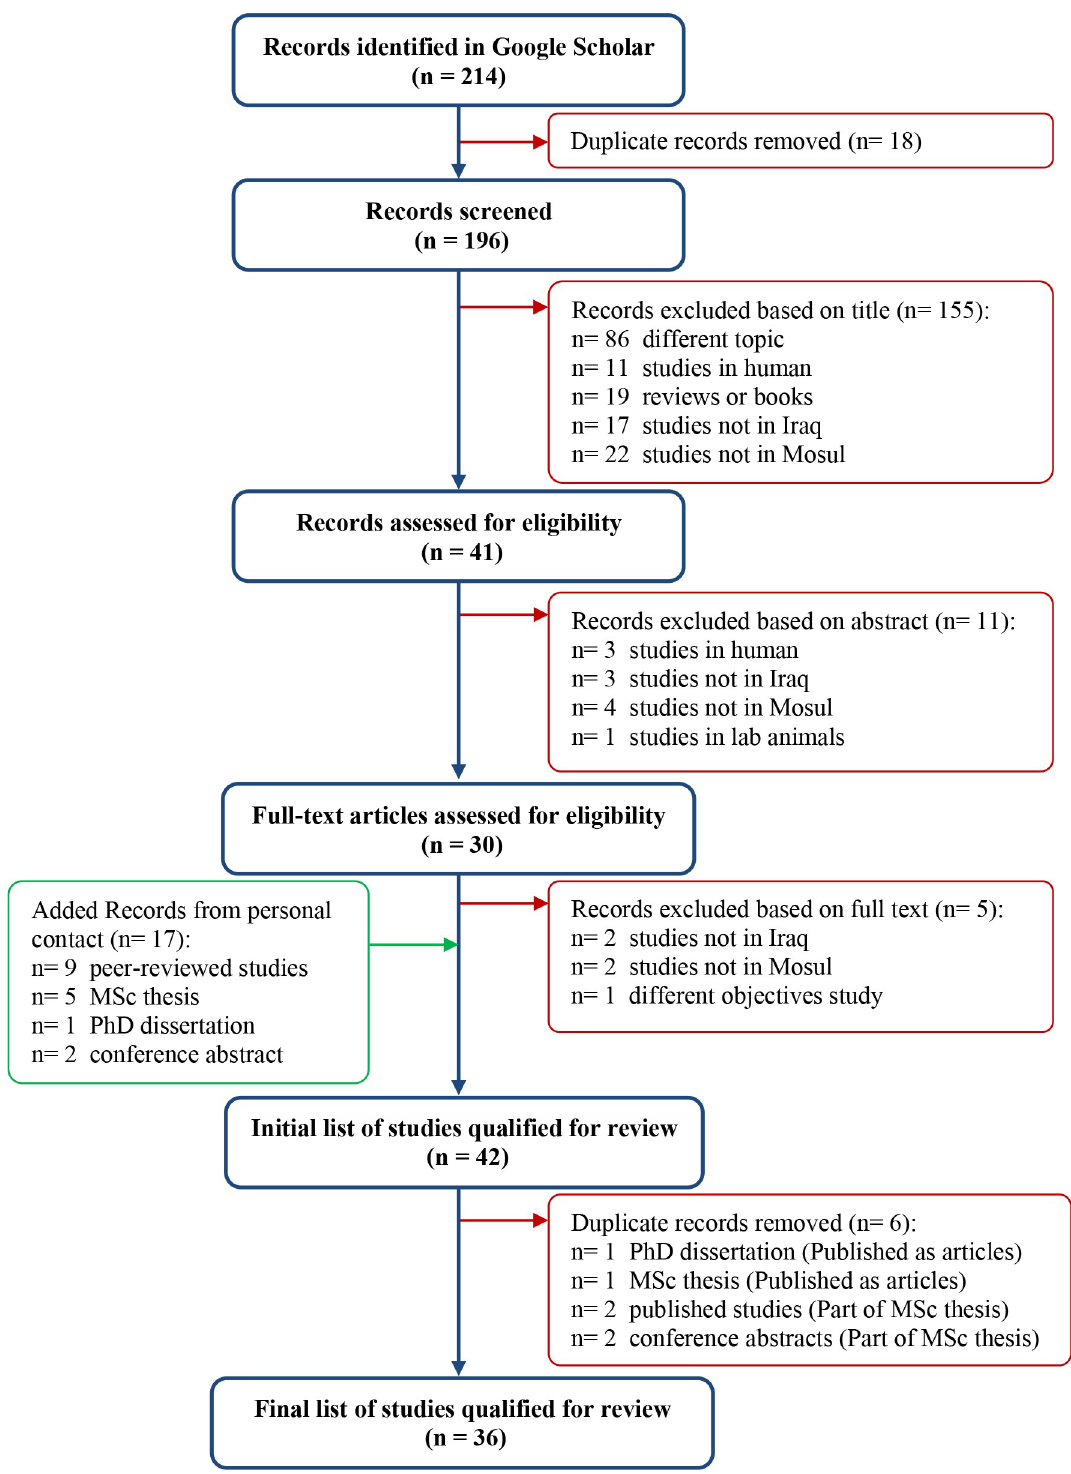
Fig 1. Flow diagram of articles selection process applied in the systematic review.